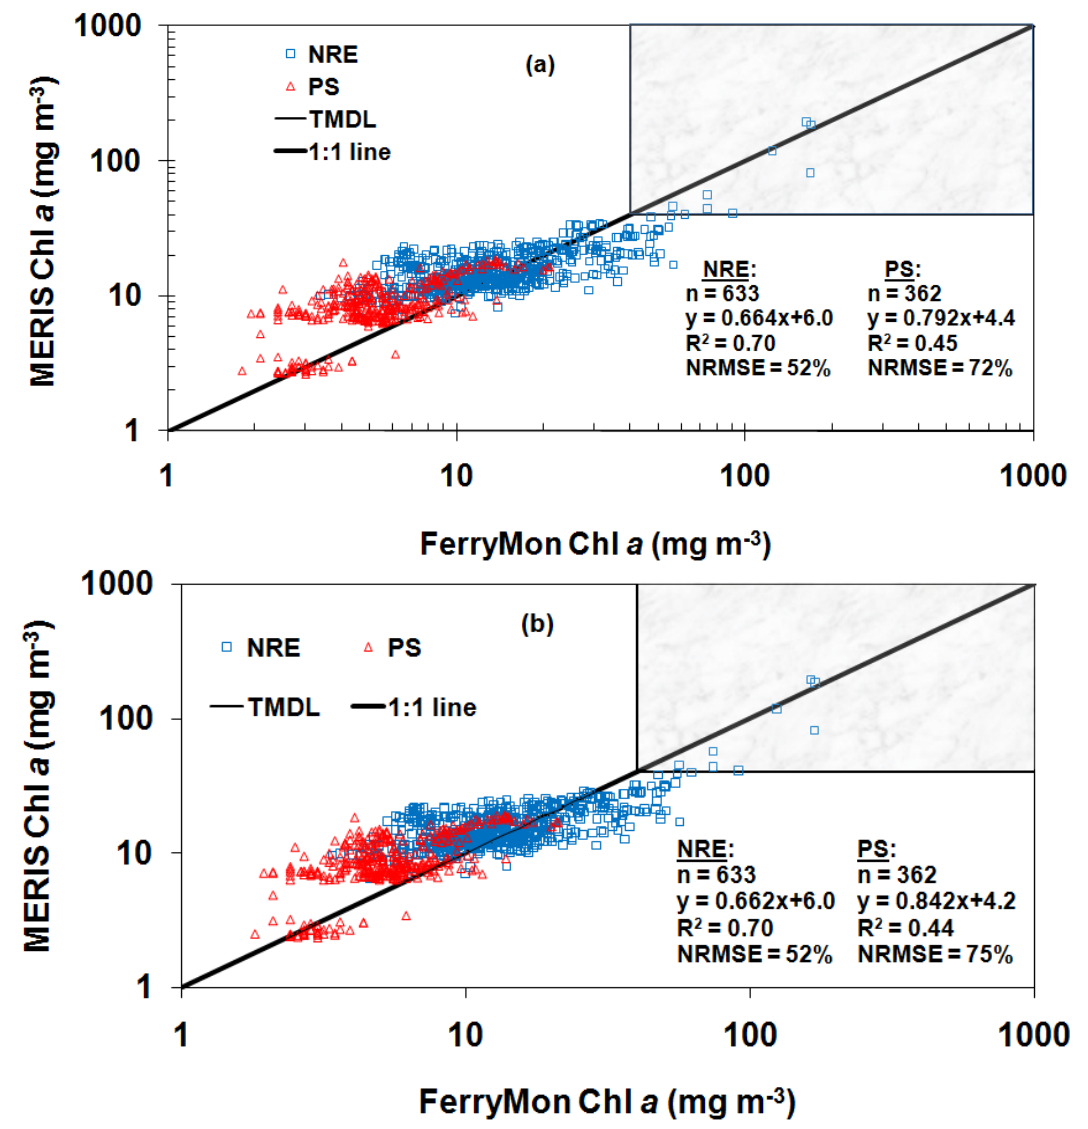
Figure 4. Scatter plot for NRE (Neuse River Estuary) and Pamlico Sound (PS) Chl values comparing MERIS retrieval estimates to FerryMon measured values for both with (a) and without (b) atmospheric correction. The Chl values exceeding Total Maximum Daily Load (TMDL) values (40 mg m −3 ) are illustrated in the upper right